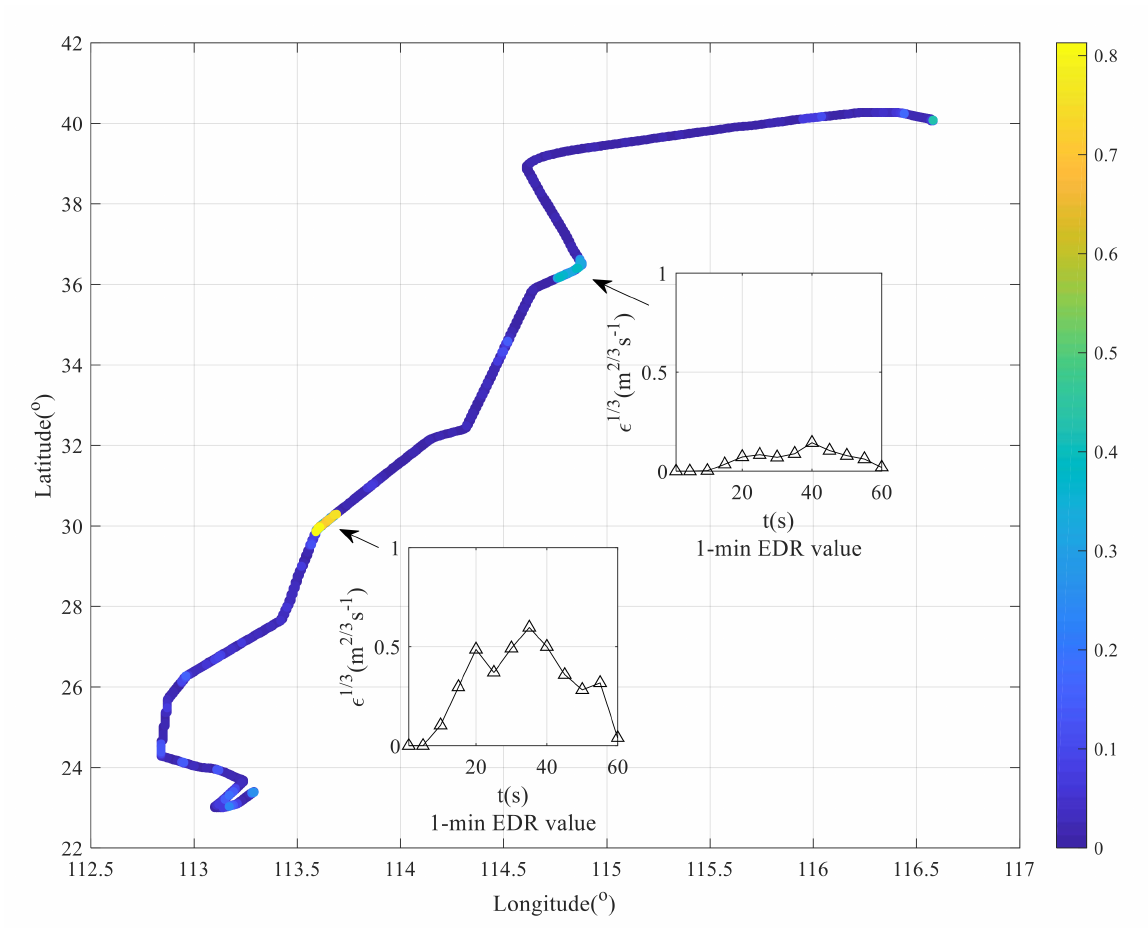
Figure 13. The estimated EDR on Beijing-Guangzhou airway.